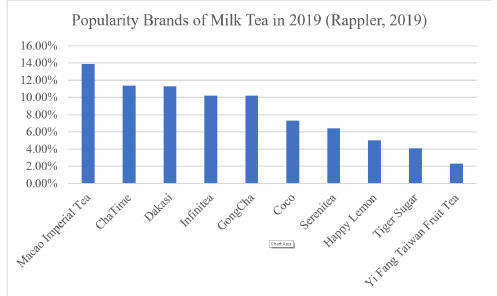
Figure 2. Milk tea popularity in the Philippines. Adapted from